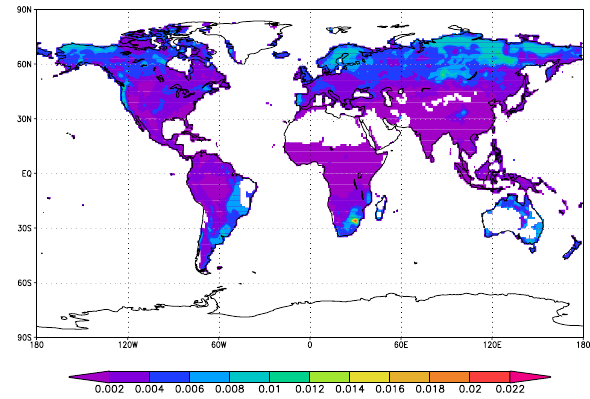
Fig. 5. The proxy given by Eq. (13) for the JJA season of the year 2006. The unit of NO 2 is 10 15 moleccm − 2 , AOD is unitless. More- over, NO 2 /AOD is normalized by a factor of